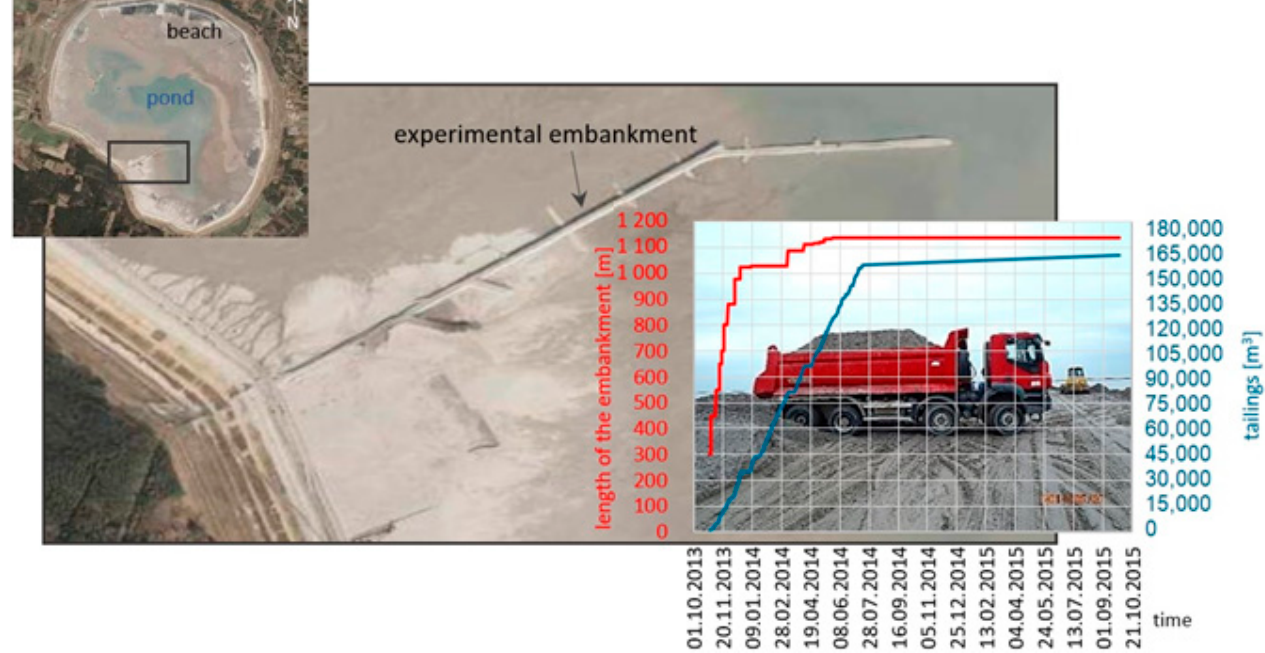
Figure 2. Experimental embankment location within the TSF and distribution of earth masses for embankment construction in time.